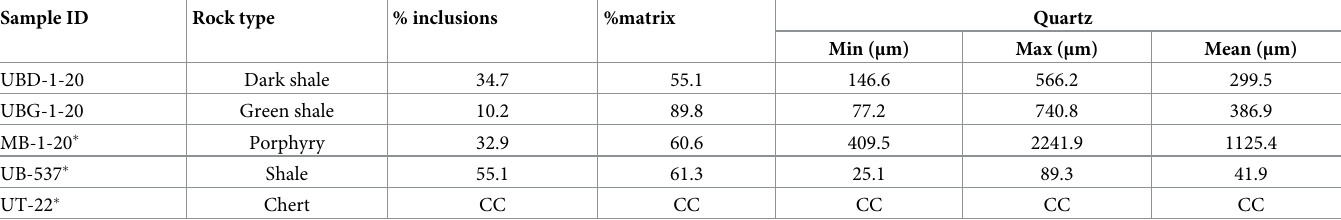
Table 5. Grain size of quartz minerals and percentage of inclusions and matrix. CC stands for cryptocrystalline grain size ( < 1 μ m). Note: samples marked with ( � ) were tested to determine their mechanical properties. Sample